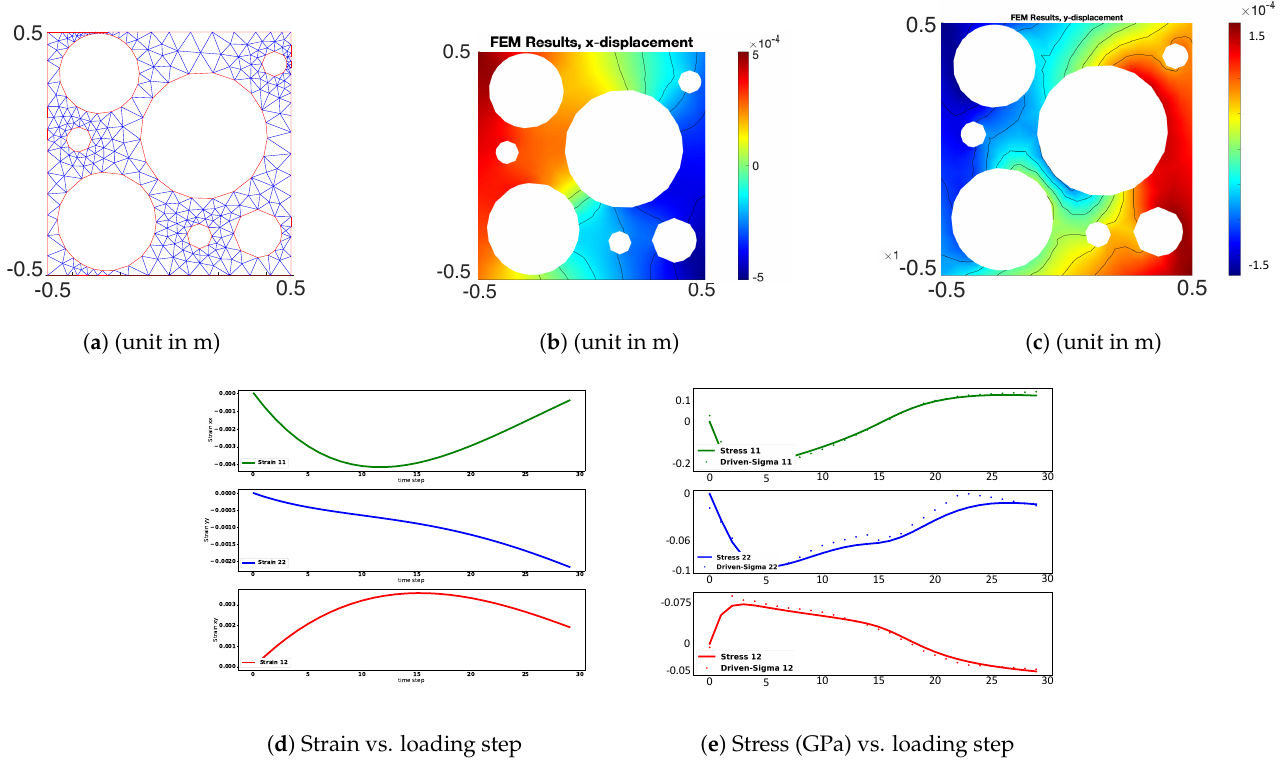
Figure 12. Test 2 for homogenization of nonlinear microstructure ( µ = 55 GPa and λ = 200 GPa), ( a ) FEM mesh, ( b ) X displacement (initial step), ( c ) Y displacement (initial step), ( d ) random generated strain, and ( e ) comparison of the homogenized effective stress and the data-driven responses.